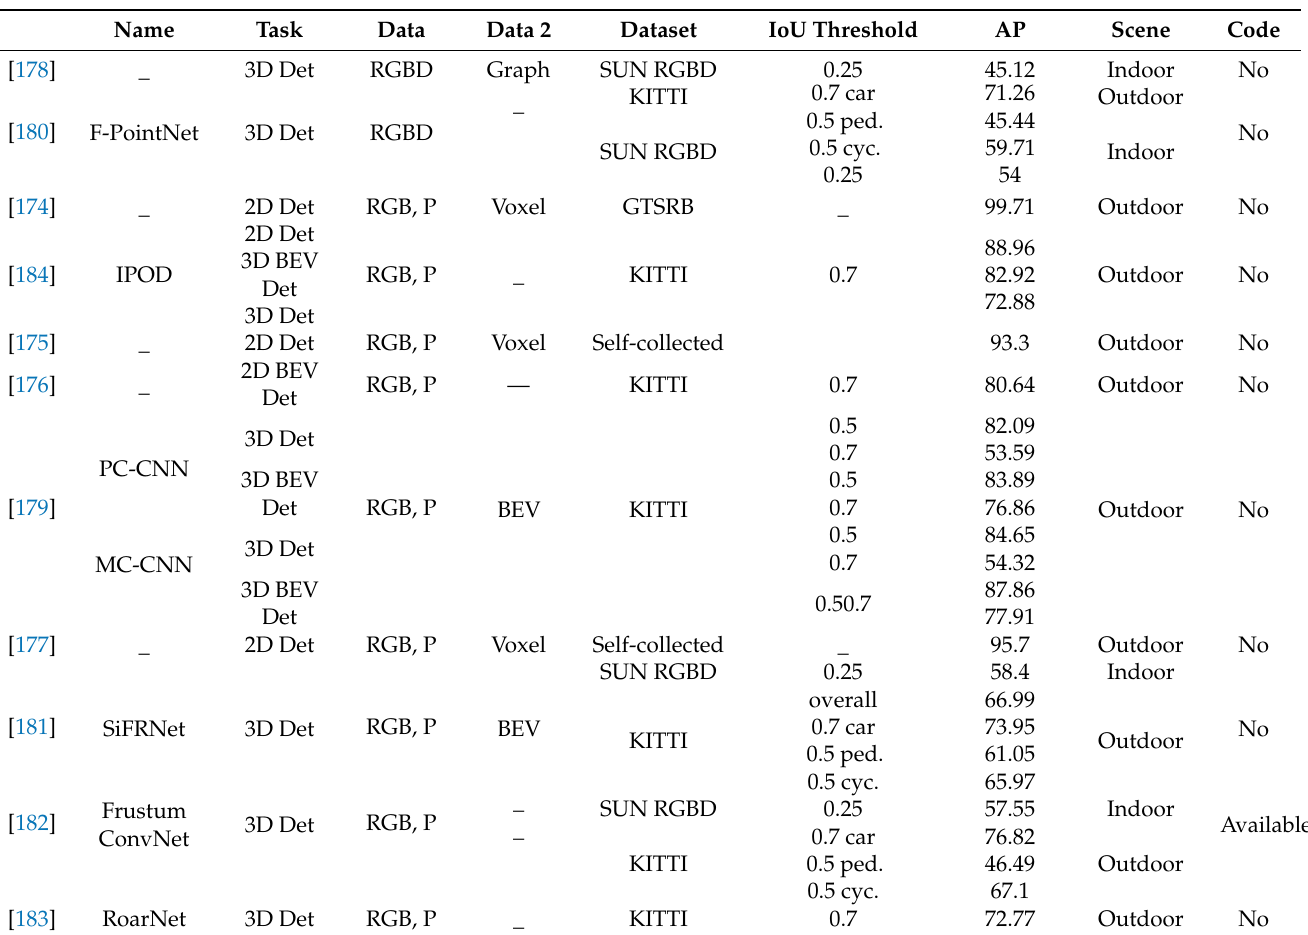
Table 9. Comparative summary of detection methods using data–result-based fusion strategy (P: point cloud; Data 2: intermediate